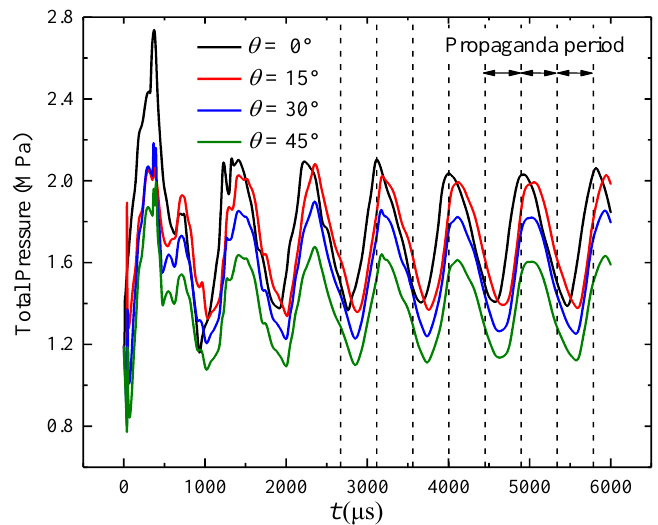
Figure 11. The time-varied outlet total pressure of the RDC with different θ.